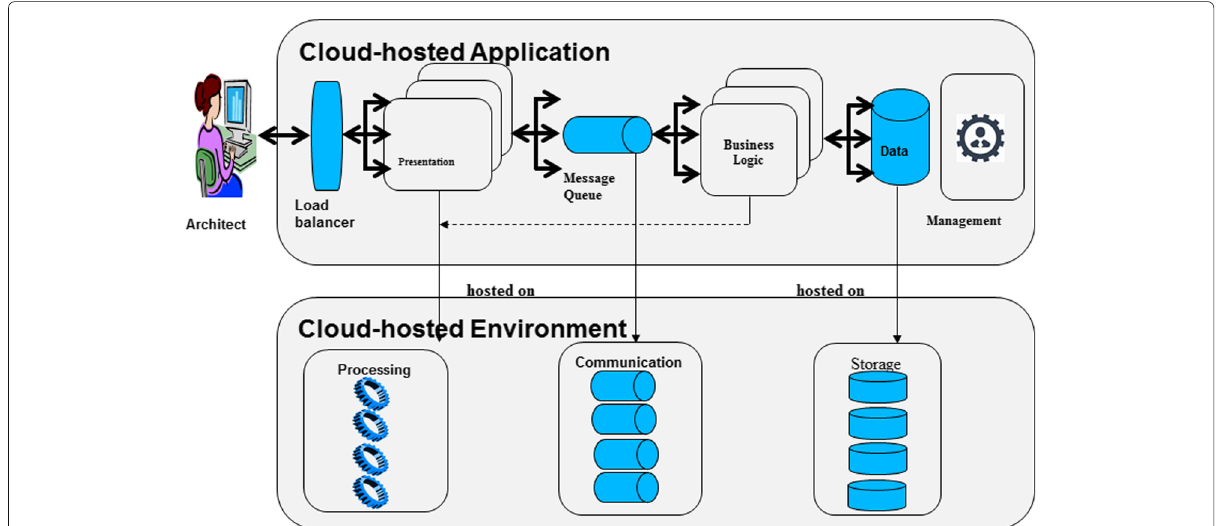
Fig. 4 System Model of a Cloud-hosted Service with multiple groups of